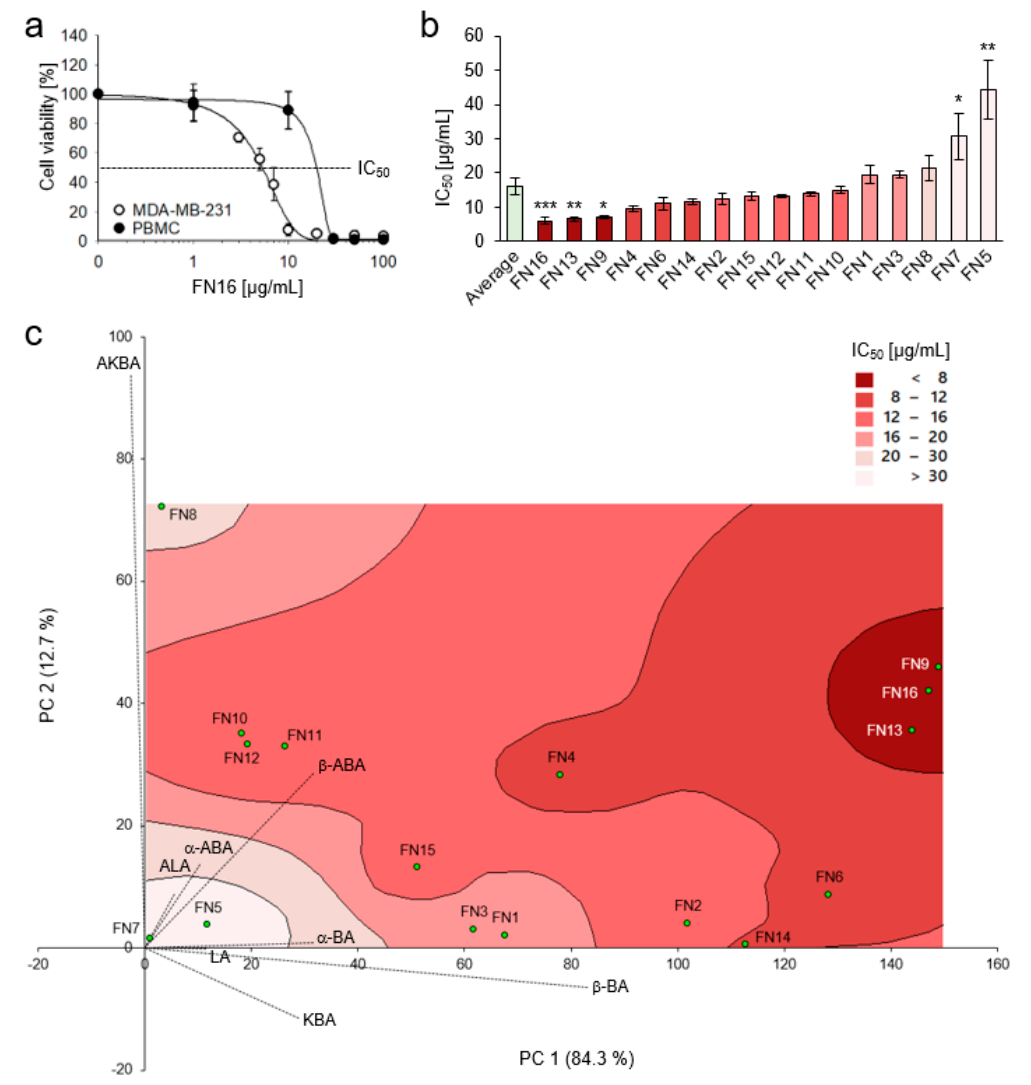
Figure 4. FNs are toxic to a TNBC cell line. ( a ) MDA-MB-231 cancer cells and peripheral blood mononuclear cells (PBMC) were treated for 72 h with FN16, and cell viability was analyzed by XTT assay ( n = 3). ( b ) Half maximal inhibitory concentrations (IC 50 ) of FNs against MDA-MB-231 cell line. Comparison of IC 50 values of individual FNs with the average IC 50 value for all FNs (15.9 µg/mL) by Box-Cox transformation, one-way ANOVA, and post-hoc Dunnett’s test. All data are mean ± SEM, n = 3 for the respective FN, n = 16 for the average value, * p < 0.05, ** p < 0.01, and *** p < 0.001. ( c ) Principal component analysis (PCA) and contour plot visualizing the correlation between toxicity of different FNs and their BAs and LAs contents.